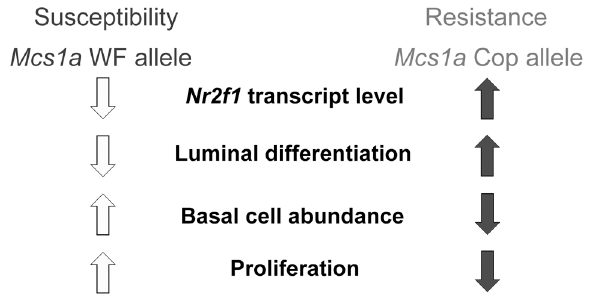
Figure 8. Proposed model for the Mcs1a breast cancer risk- affecting mechanism. The Mcs1a resistance allele displays increased mammary Nr2f1 transcript levels as compared with the susceptible allele. Lower Nr2f1 transcript levels in the mammary gland are associated with susceptibility, a lower percentage of luminal rat mammary epithelial cells (RMEC), a higher percentage of basal RMECs and increased colony-forming ability of the clonogenic luminal RMEC population, indicative of increased